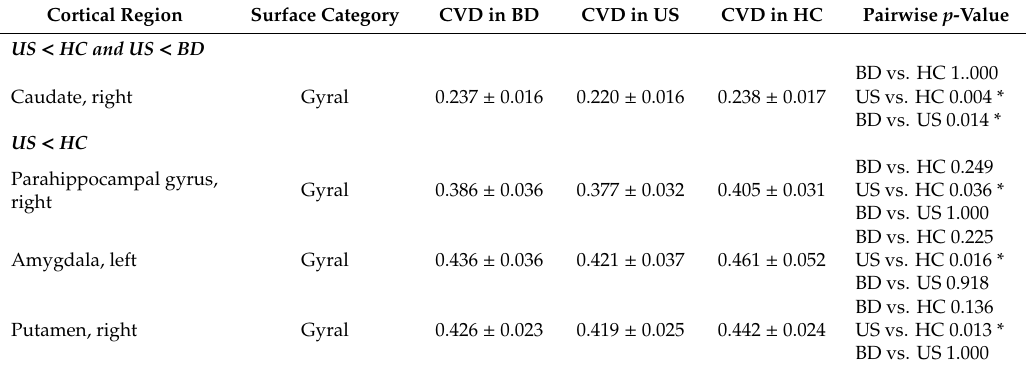
Table 4. Significant di ff erences in CVD values in una ff ected siblings, compared with healthy controls and BD